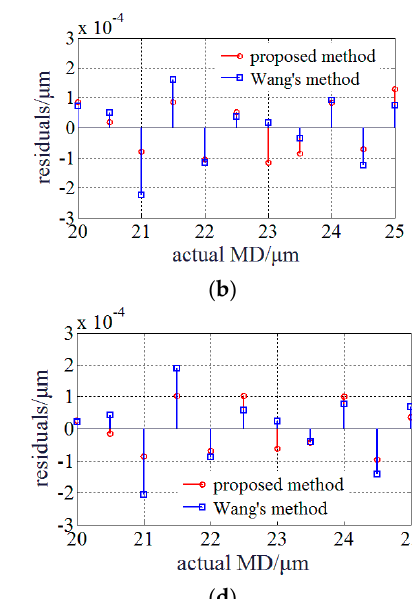
Figure 5. Simulation of PLCI for MADM with a BLS of measured profile: ( a ) The profile of the Gauss BLS; ( b ) Relationship between envelope and zero ‐ order PLCIF peak center; ( c ) PLCIF of BLS in measured profile: The solid and dotted lines represent the PLCIFs at different MDs. The blue and red lines represent the measured PLCIFs achieved by SC and envelopes curves achieved by FFT method.